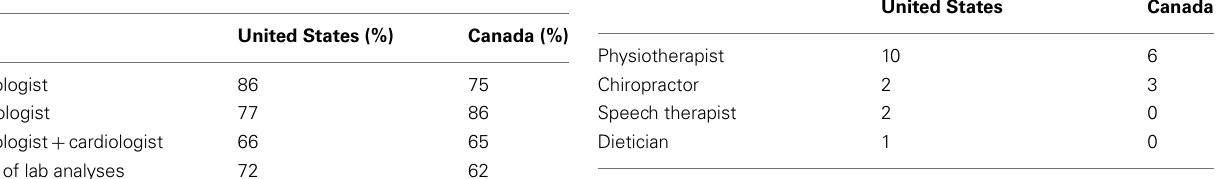
Table 1 | Percentage of survey respondents who saw specialists and had a lab analysis done at least once during the 12-months observation period.